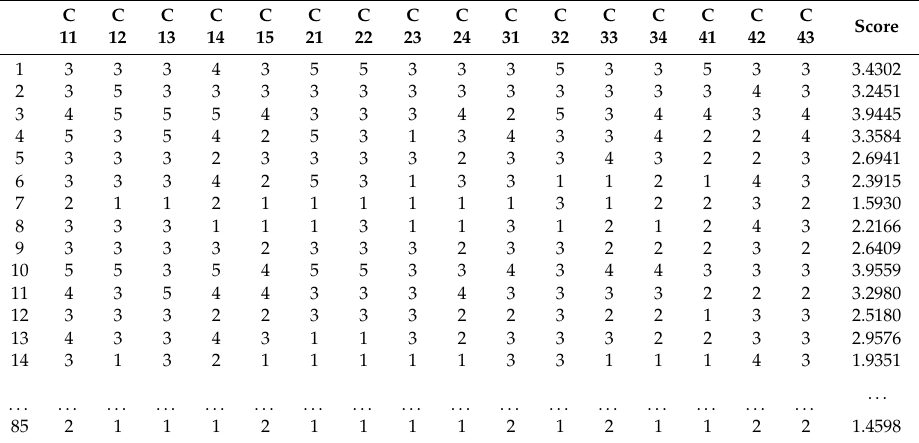
Figure 6. Initial weights of the transient population community resilience to disaster. Table 2. Partial samples and results of the urban village